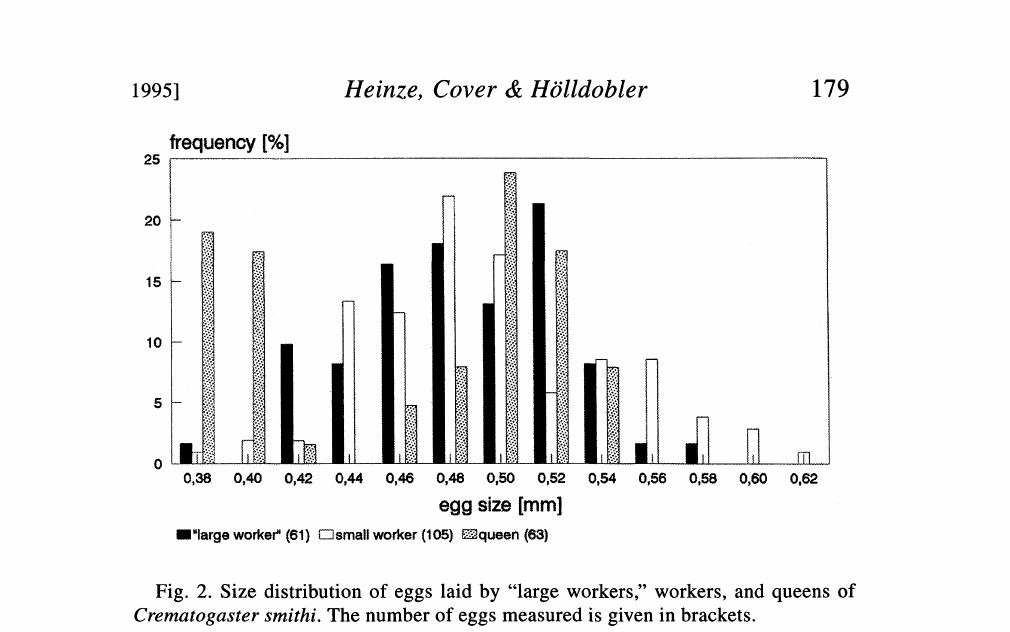
Fig. 2. Size distribution of eggs laid by "large workers," workers, and queens of Crematogaster smithi. The number of eggs measured is given in brackets. trophic eggs. Surprisingly, the percentage of these smallest eggs was significantly larger in queens (12 of a total of 63 eggs) than in "large workers" (1 of 61) and workers (3 of 105) (2-Test with Yates Correction: "large workers" vs. queens: 2 workers vs. queens: